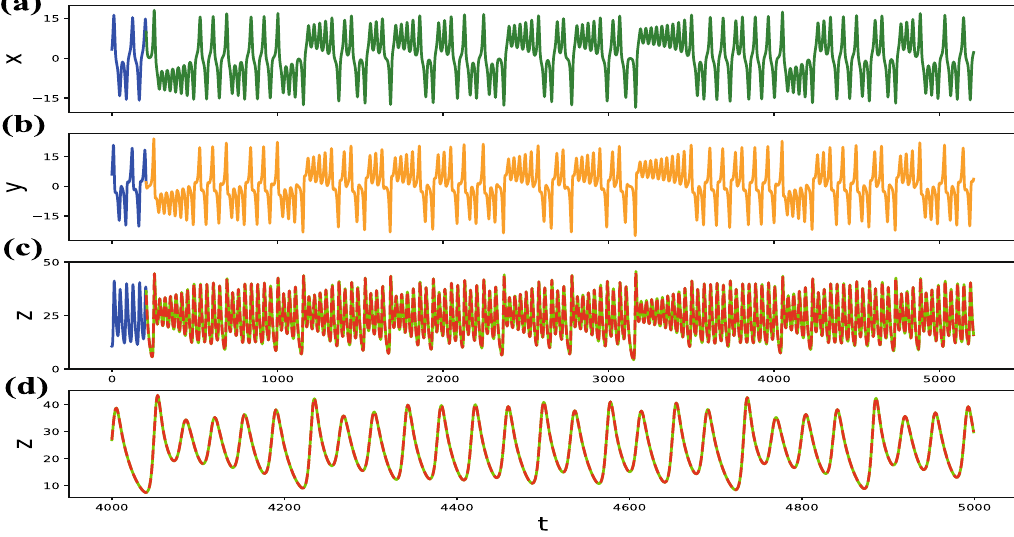
Figure 2. Reconstruction of the Lorenz system (Eq. 4). ( a – c ) The sequence diagram of variables x , y , z in the xy − z mode, the blue solid line is the training length ( T train = 205). For the reconstruction phase, the green and orange solid lines represent the trajectories of measured variables x and y , respectively, and the bright green solid line represents the actual value of variable z . The red dotted line represents the trajectories of reconstructed variable z calculated by reservoir computing, for T test = 5000. Apparently, using very little data to train the “calibrated” model, then the reconstructed variable can be reconstructed for a fairly long term. ( d ) A partial enlargement of ( c ) for t between 4000 and 5000, the dotted lines (reconstructed values) almost coincide with the solid lines (actual values), demonstrating the model’s ability to accurately reconstruct.